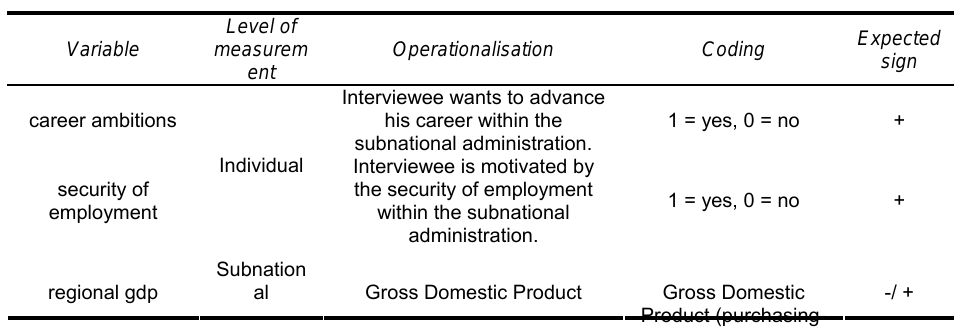
Table 8: Independent variables